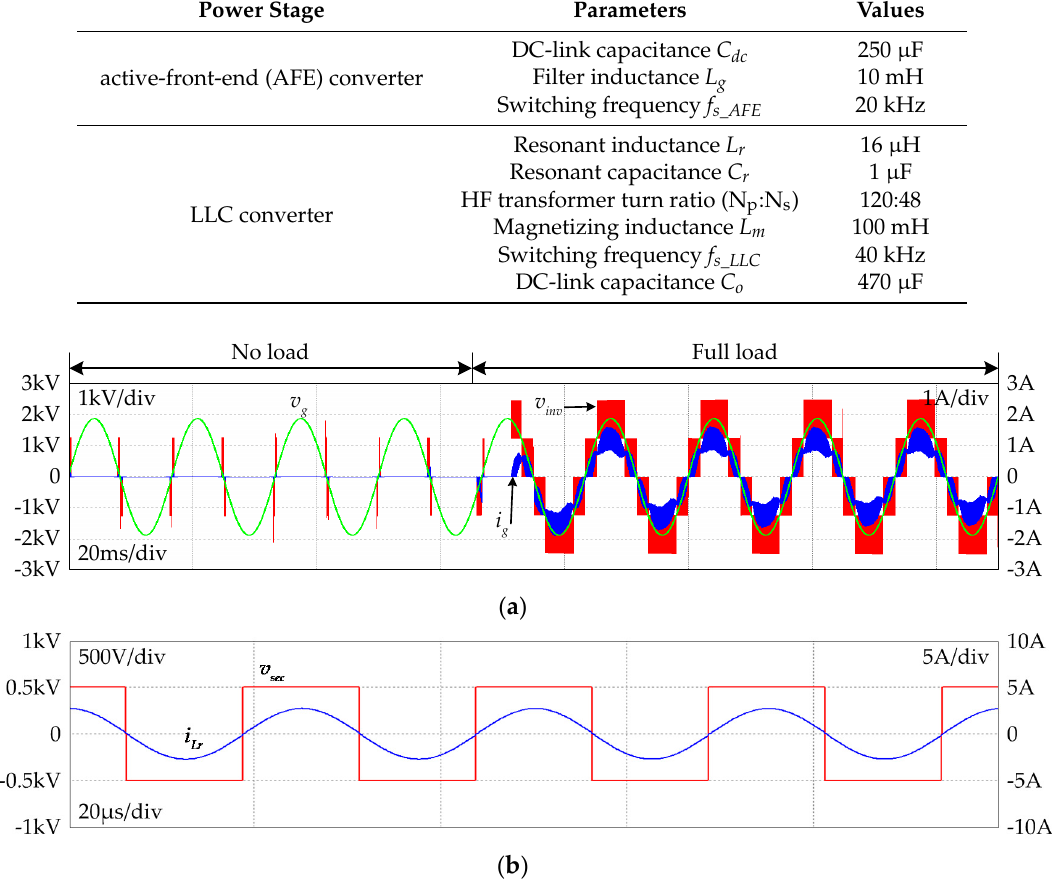
Figure 13. Simulation results. ( a ) v g , v inv , and i g in transient state; ( b ) v sec and i Lr in steady-state.